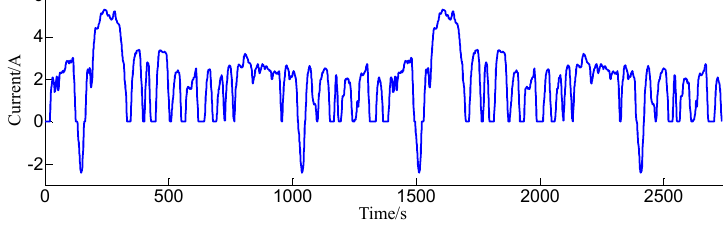
Figure 10. The input current waveform.